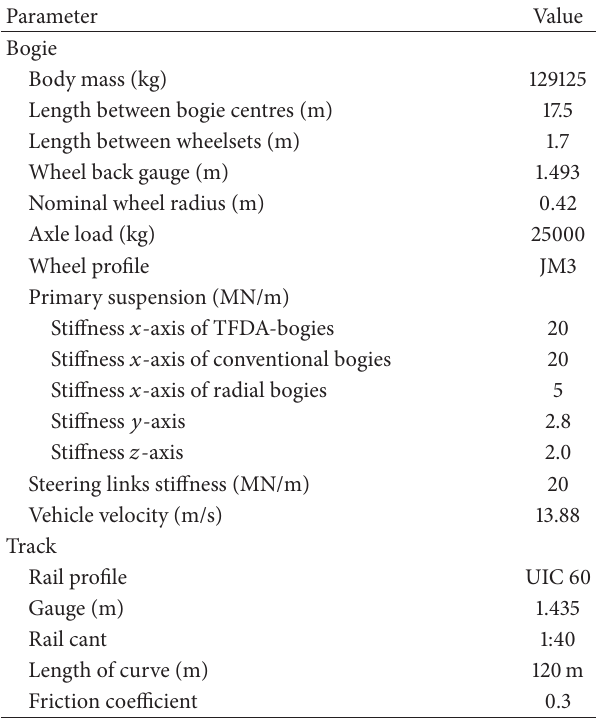
Figure 4: Diagram of the active control of TFDA-bogies. Table 1: Common vehicle